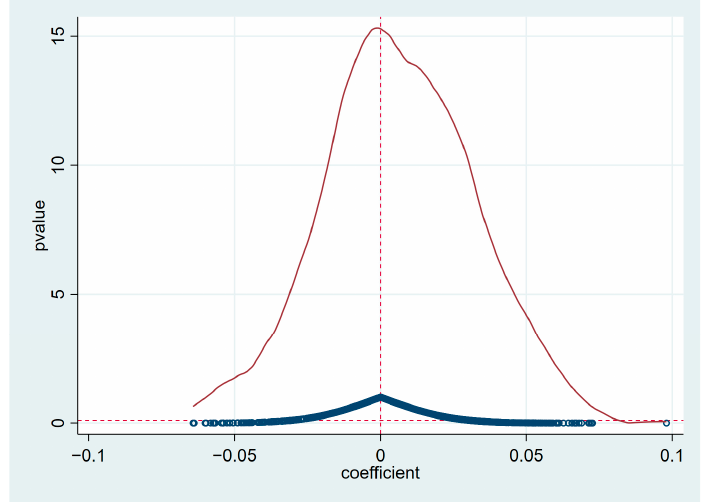
low circles are the p -values of the 1000 pseudo-regressions; and the red dashed line at the level of the horizontal axis indicates p = 0.1. Based on this, it is obvious from Figure 4 that, first, the estimated coefficients of the core explanatory variables of the 1000 pseudo-